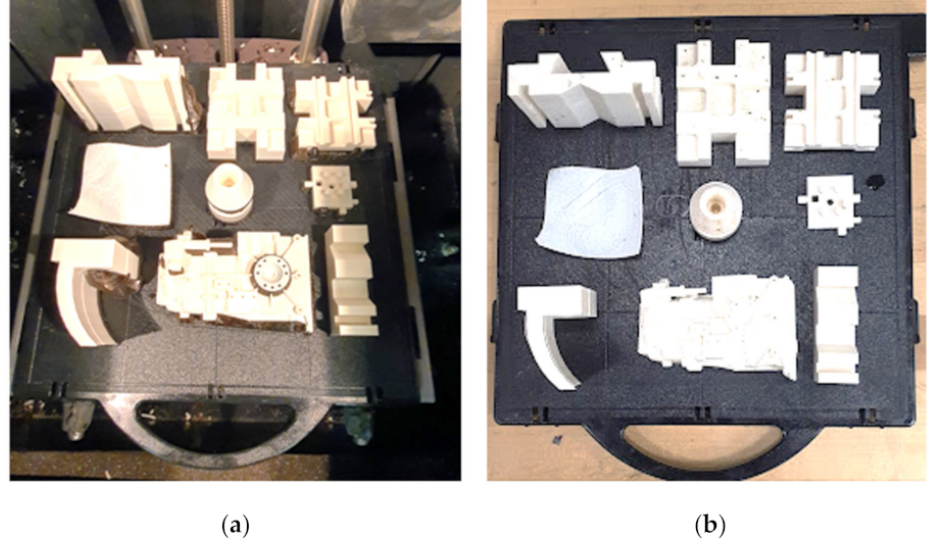
Figure 10. Fabricated components manufactured using FDM. ( a ) With supports; ( b ) After remov- ing